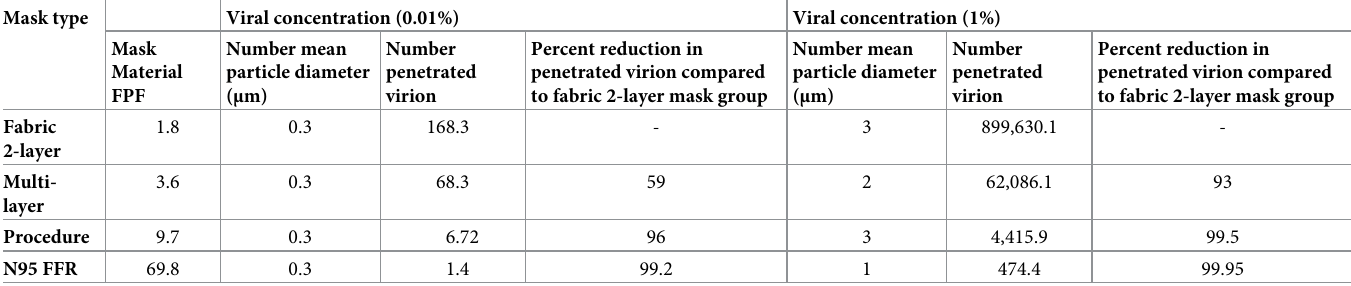
Table 2. Percent reduction in penetrated virion for each mask group compared to the fabric 2-layer mask: Results for 0.3 μ m particle diameter at a viral concentra- tion of 0.01%, and results for the particle diameter associated with the maximum virion penetration at 1.0% concentration. Mask type Viral concentration